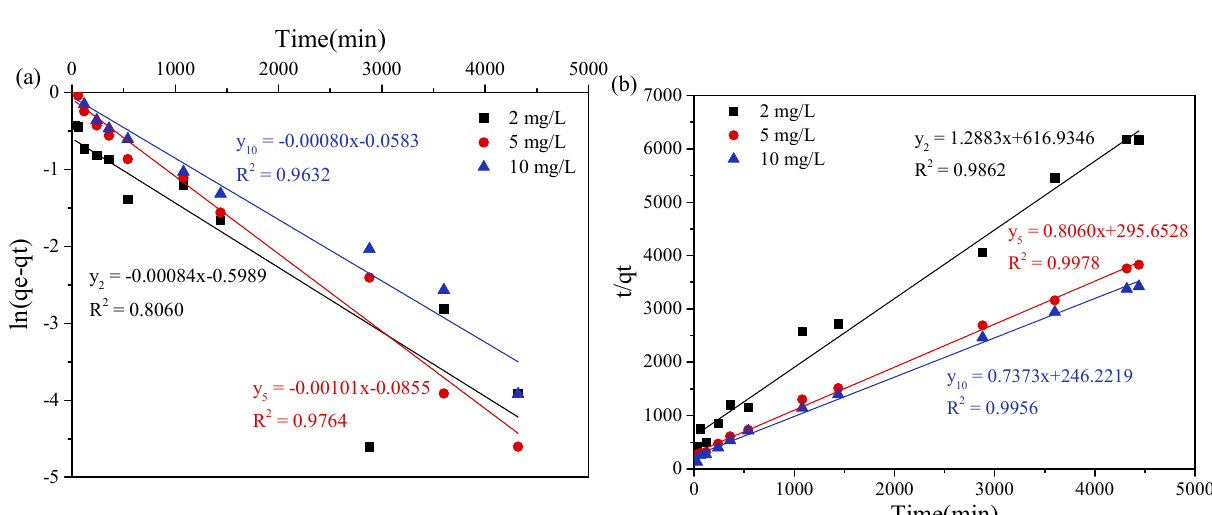
Figure 11. Fitting of the fluoride adsorption process with the quasi-first-order kinetics model ( a ) and the quasi-second-order kinetics model ( b ).